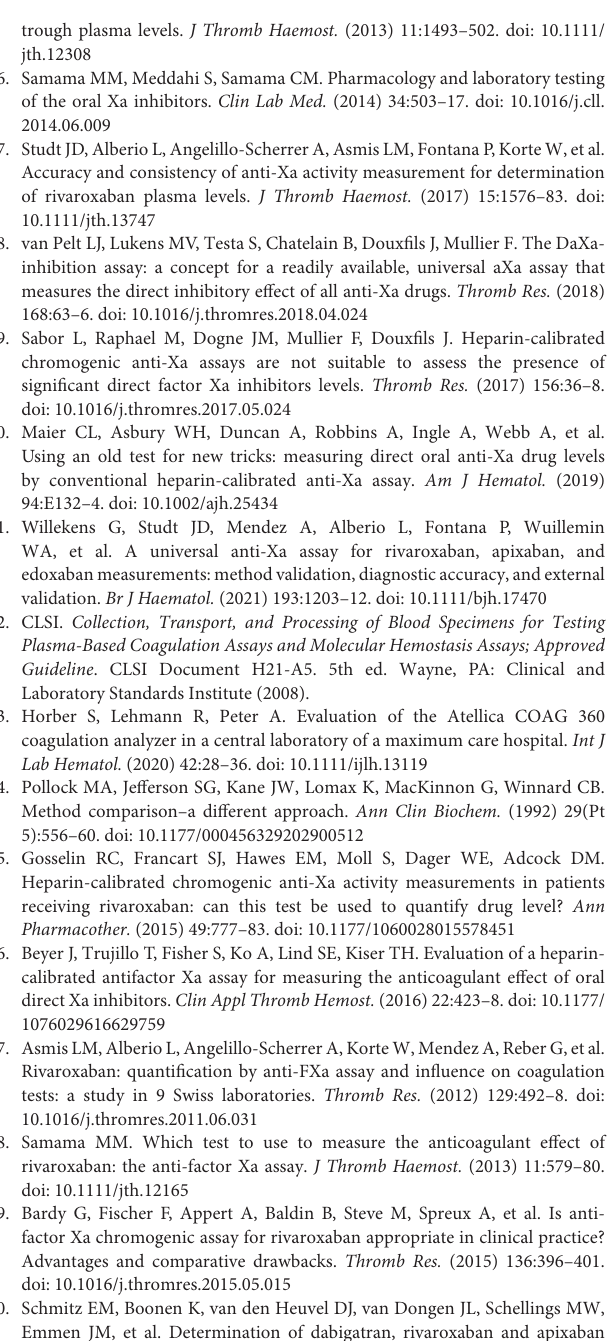
Supplementary Figure 1 | A modified Bland–Altman plot using ratios to determine a possible systematic bias over the range of measurements. The bias and the upper and lower limit of agreement is